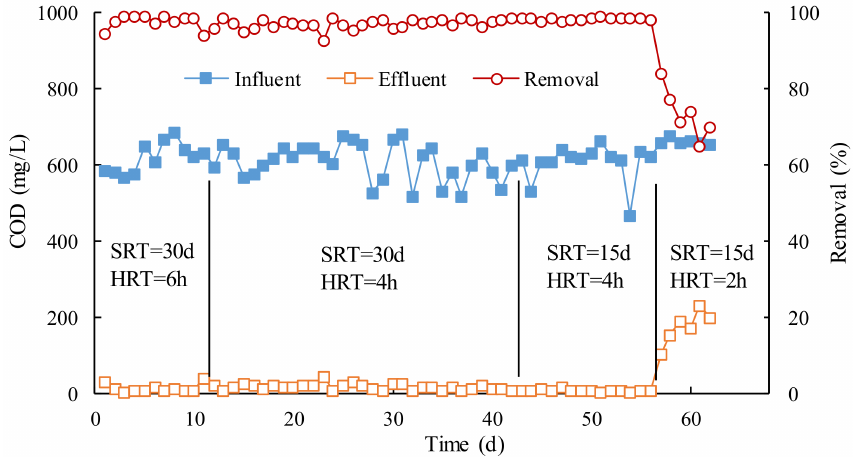
Figure 1. Effect of SRT and HRT on removal of organic